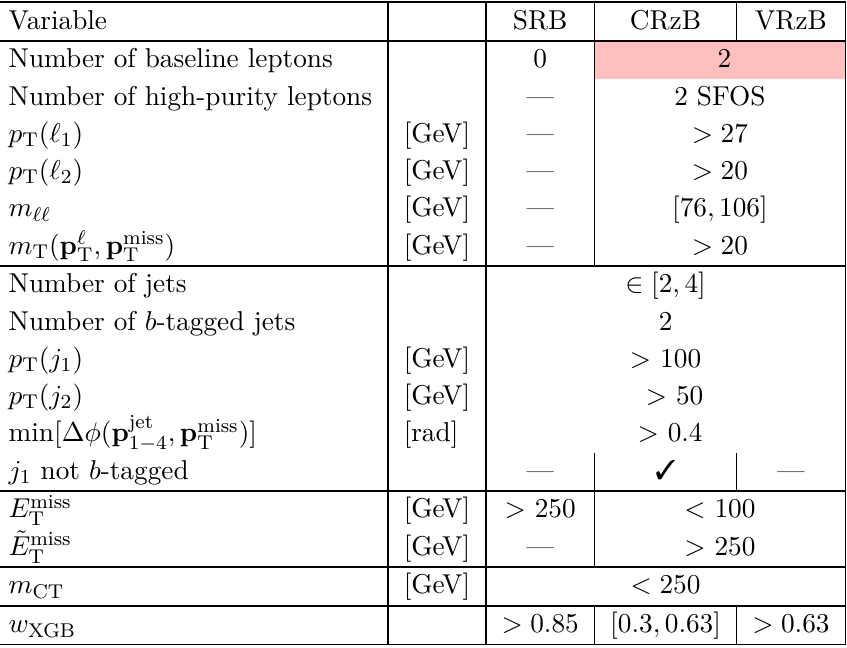
Table 3 . SRB signal, control and validation region definitions. Pink cells for the control and validation regions’ columns indicate which selections ensure that the regions are orthogonal to the